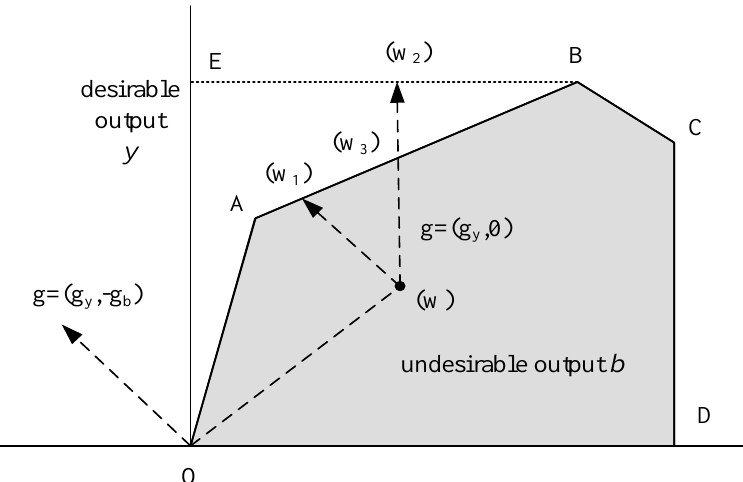
Figure 1. Environmental production technology output sets and the directional distance function.